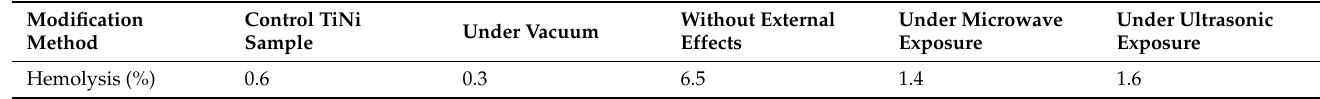
Table 2. Percentage of hemolysis for samples modified with BU[6] by different methods on the porous TiNi surface.